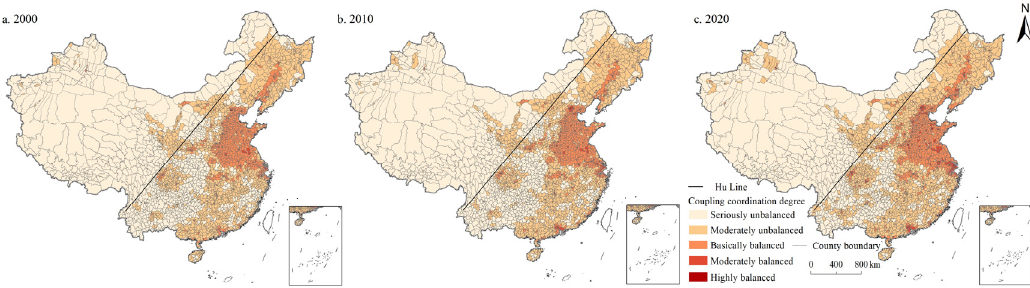
Figure 6. Spatial distribution of coordination degree of PSI and ESI in China during 2000–2020.